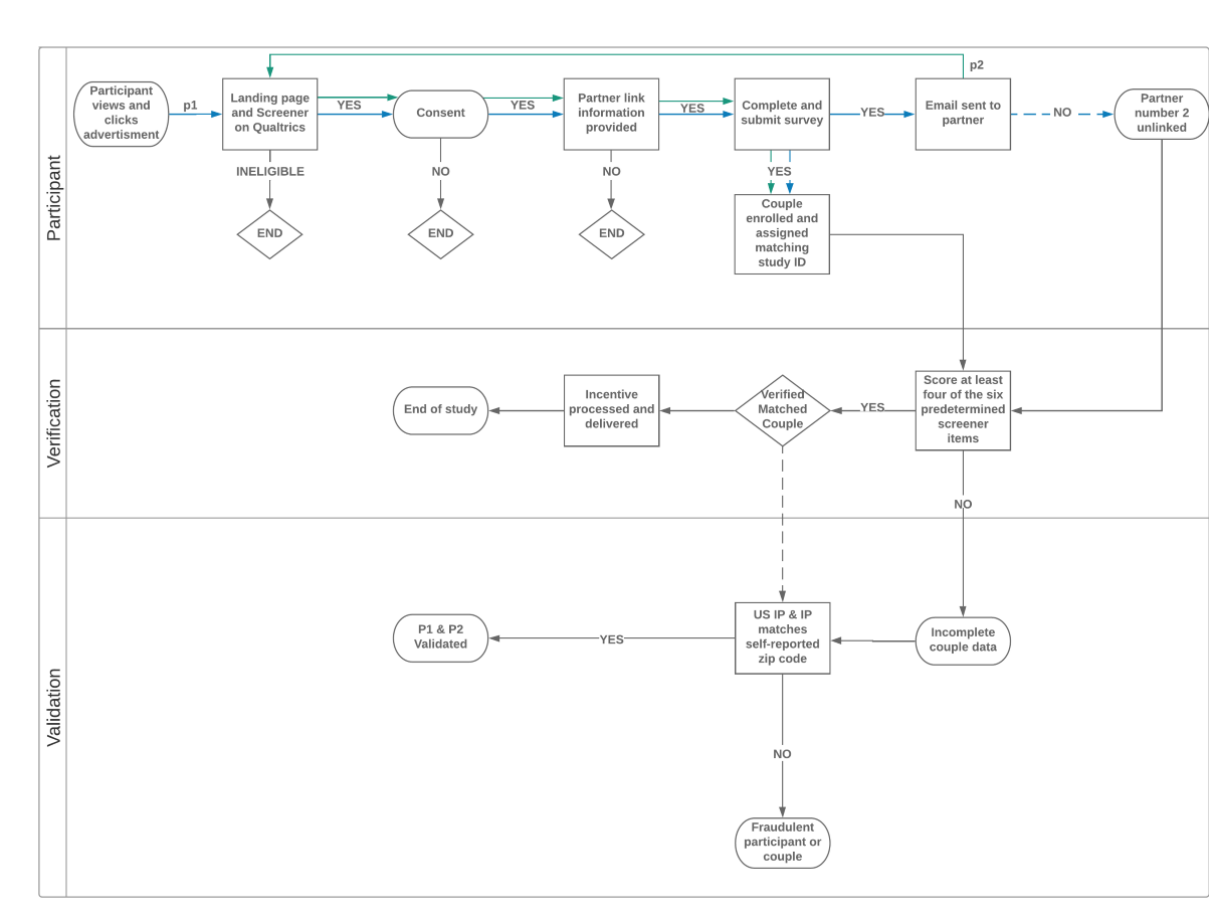
Figure 1. Overview of screening and enrollment procedures used. IP: internet protocol; p1: partner 1 ; p2: partner